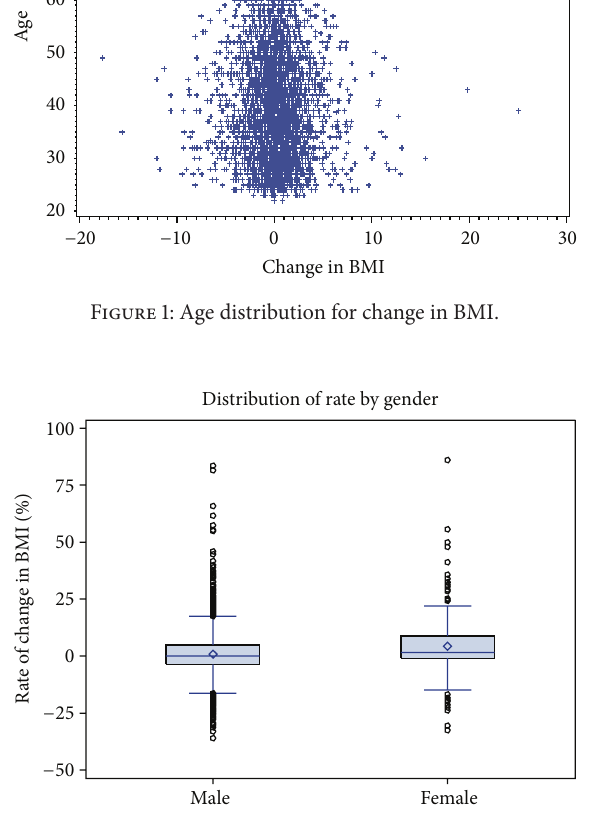
Figure 2: Rate of change in BMI during incarceration.